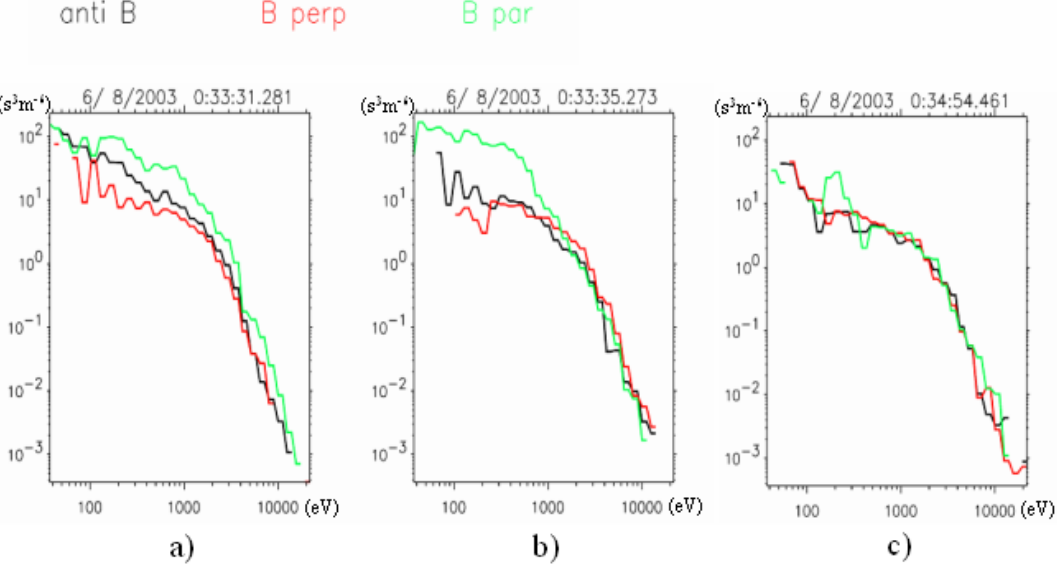
Fig. 7. Selected electron distributions parallel, anti-parallel, and perpendicular to the magnetic field in the cavity. The first and second distributions parallel to the magnetic field manifest the broad type of bump-on-tail pattern, while the third distribution shows the narrow type of bump-on-tail